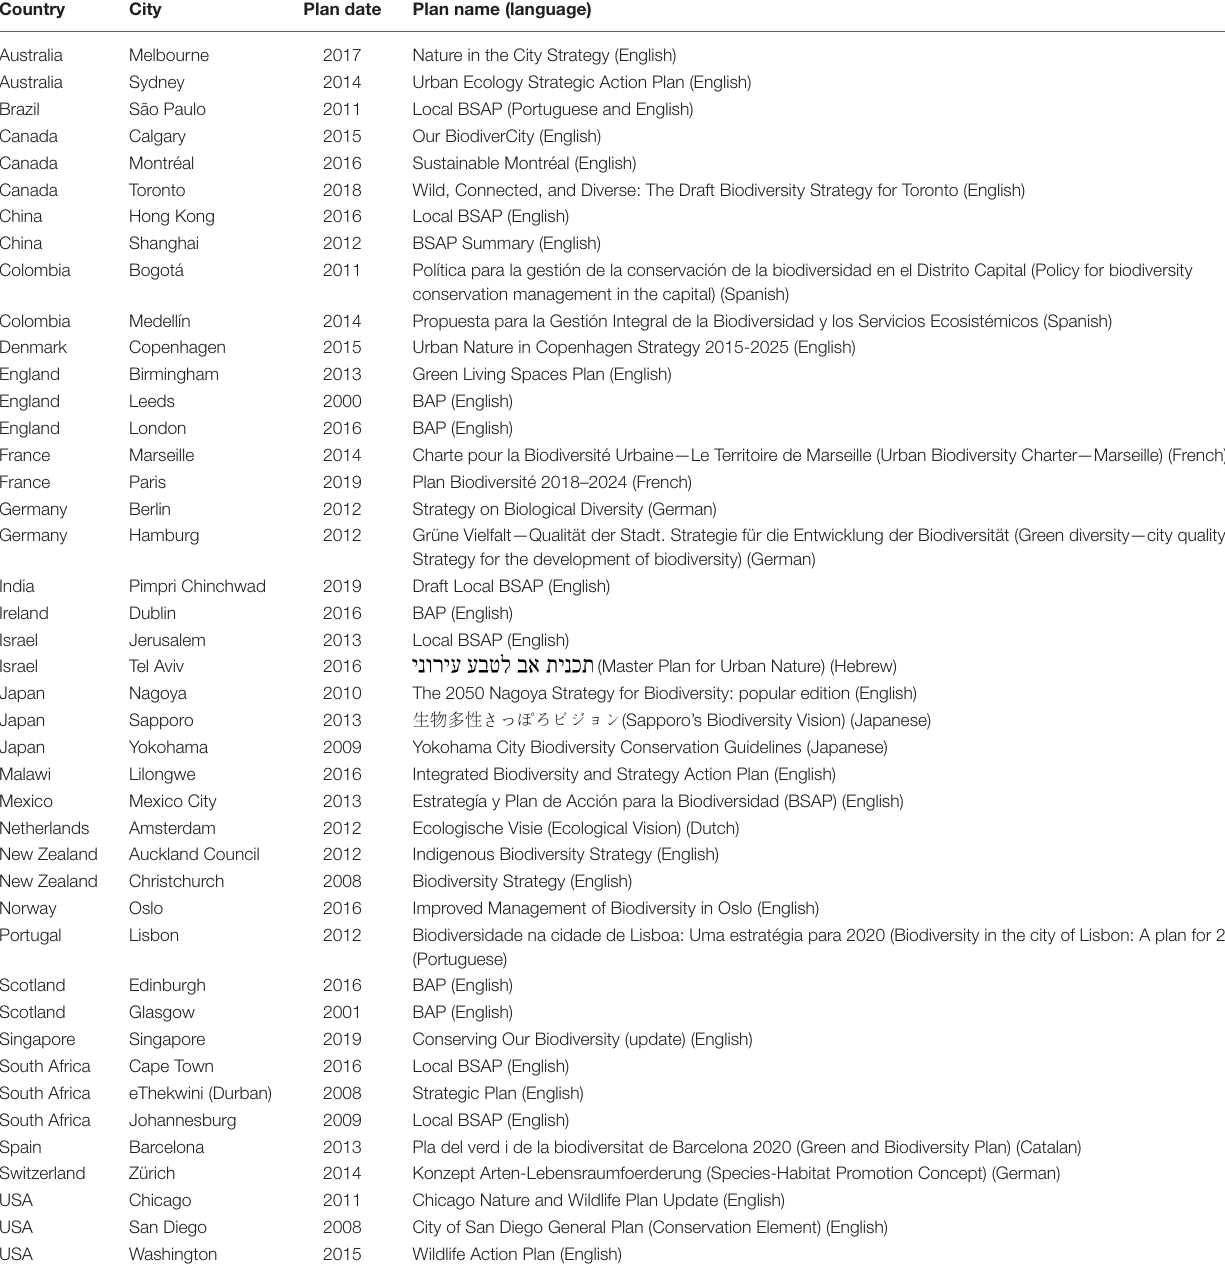
TABLE 1 | List of the 44 cities and their plans included in this study.